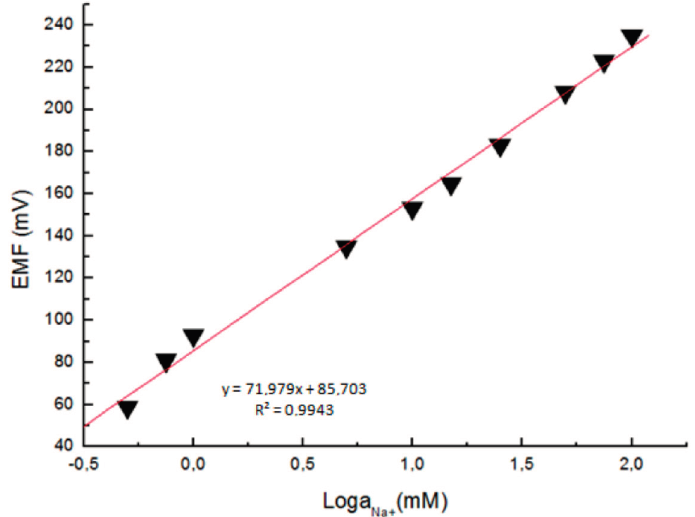
Figure 9. A calibration curve showing the electrochemical potential difference between the Na + -selective ZnO nanorod and the Ag/AgCl reference microelectrodes vs. the Na + concentration